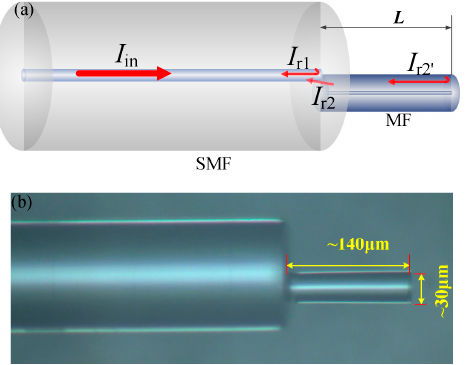
Figure 1. ( a )Schematic structure of the tip-FPI; ( b ) top view of microscope of a tip-FPI sample. Figure 1. ( a ) Schematic structure of the tip-FPI; ( b ) top view of microscope of a tip-FPI